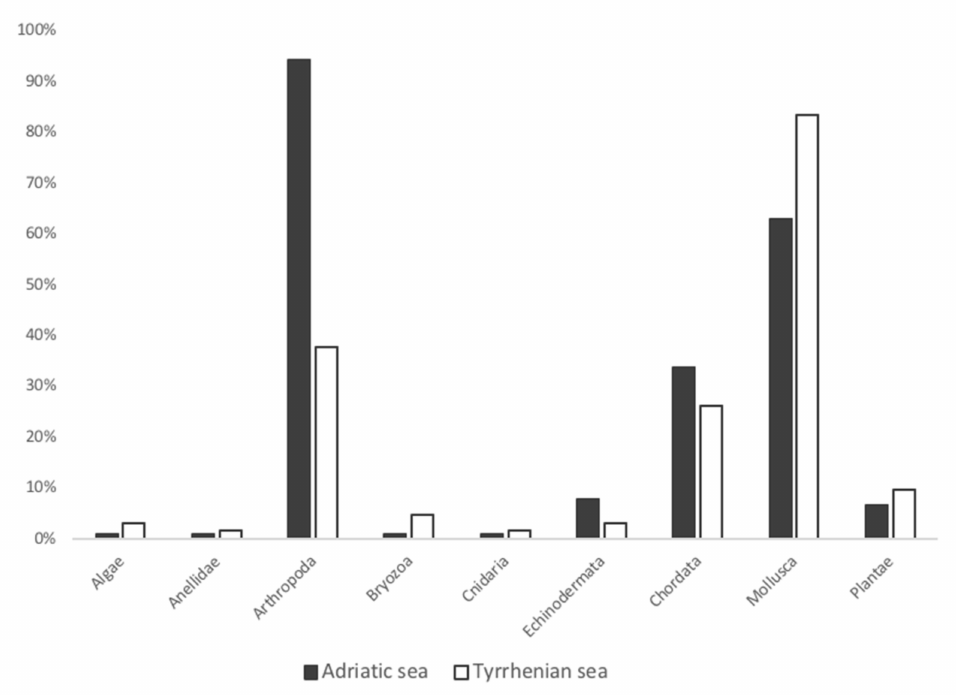
Figure 2. Frequency of occurrence of the phyla evaluated. Adriatic Sea FO%: Arthropoda, 94.4%; Mollusca, 62.9%; Chordata, 33.7%; Echinodermata, 8.9%; Plantae, 6.7%; Cnidaria, 1.1%; Bryozoa, 1.1%; Algae, 1.1%; Annelida, 1.1%. Tyrrhenian Sea FO%: Mollusca, 83.6%; Arthropoda, 37.7%; Chordata, 26.2%; Plantae, 9.8%; Bryozoa, 4.9%; Echinodermata, 3.3%; Algae, 3.3%; Cnidaria, 1.6%; Annelida,